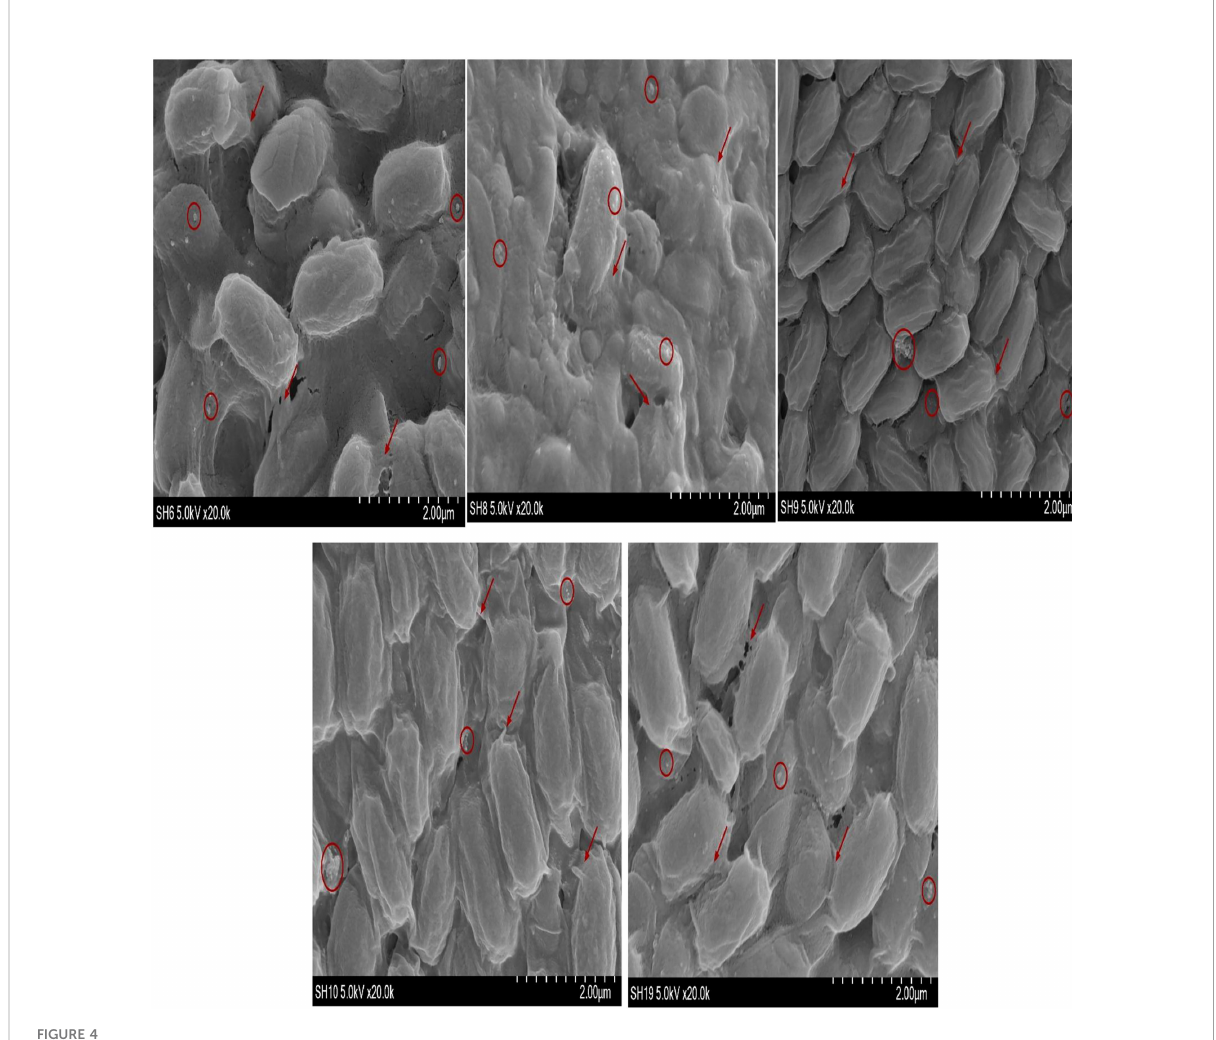
FIGURE 4 Scanning electron microscopy images of fi ve bacterial isolates (scale bar, 2.00